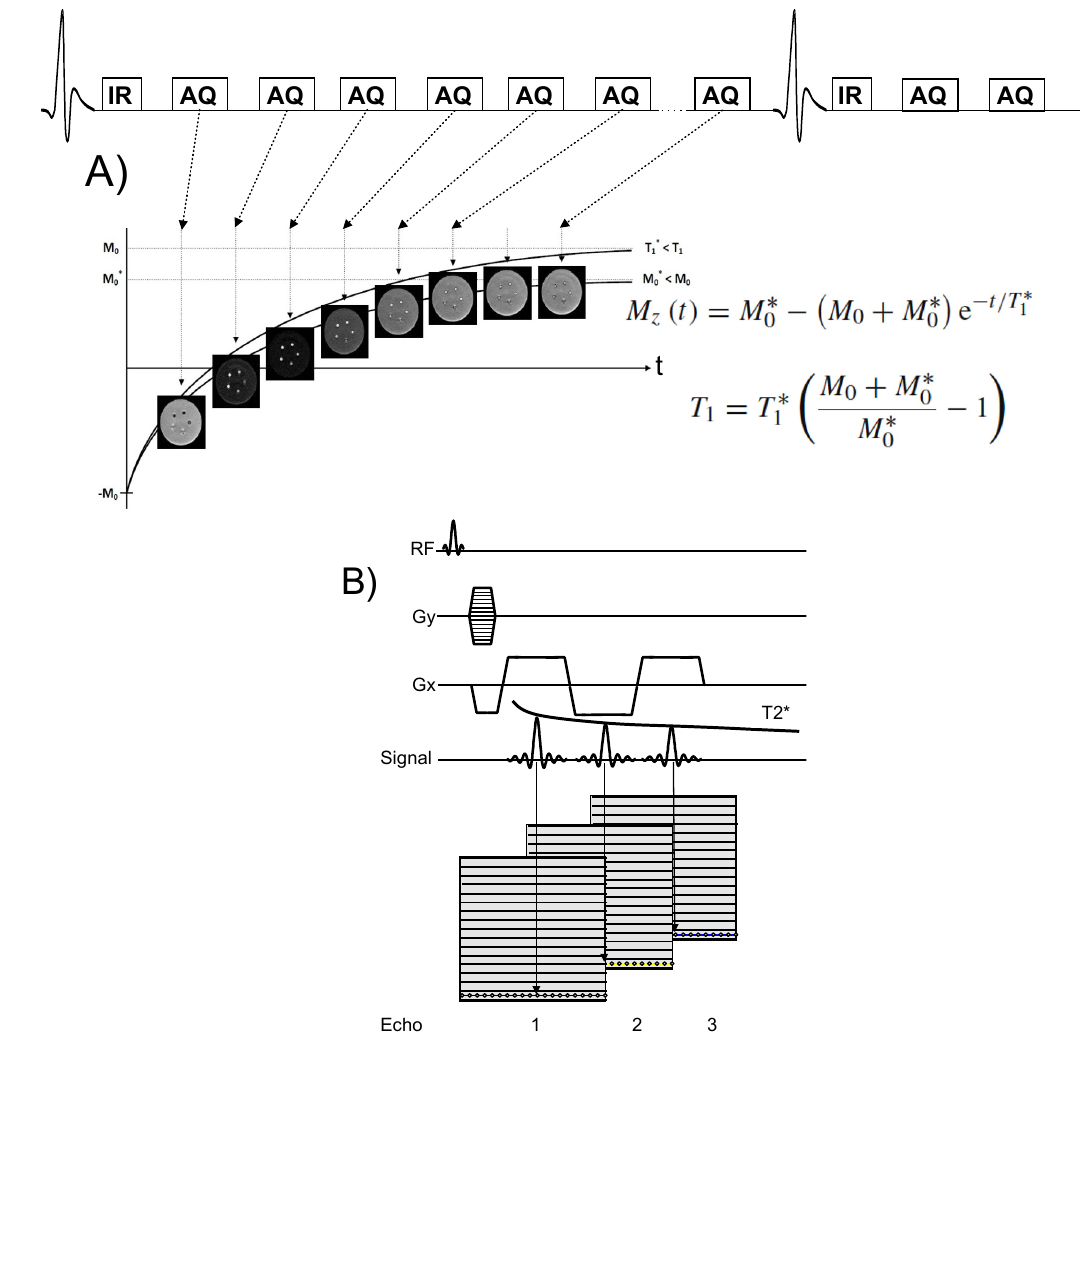
Figure 3. ( A ) Schematic of inversion recovery Look Locker (LL) T